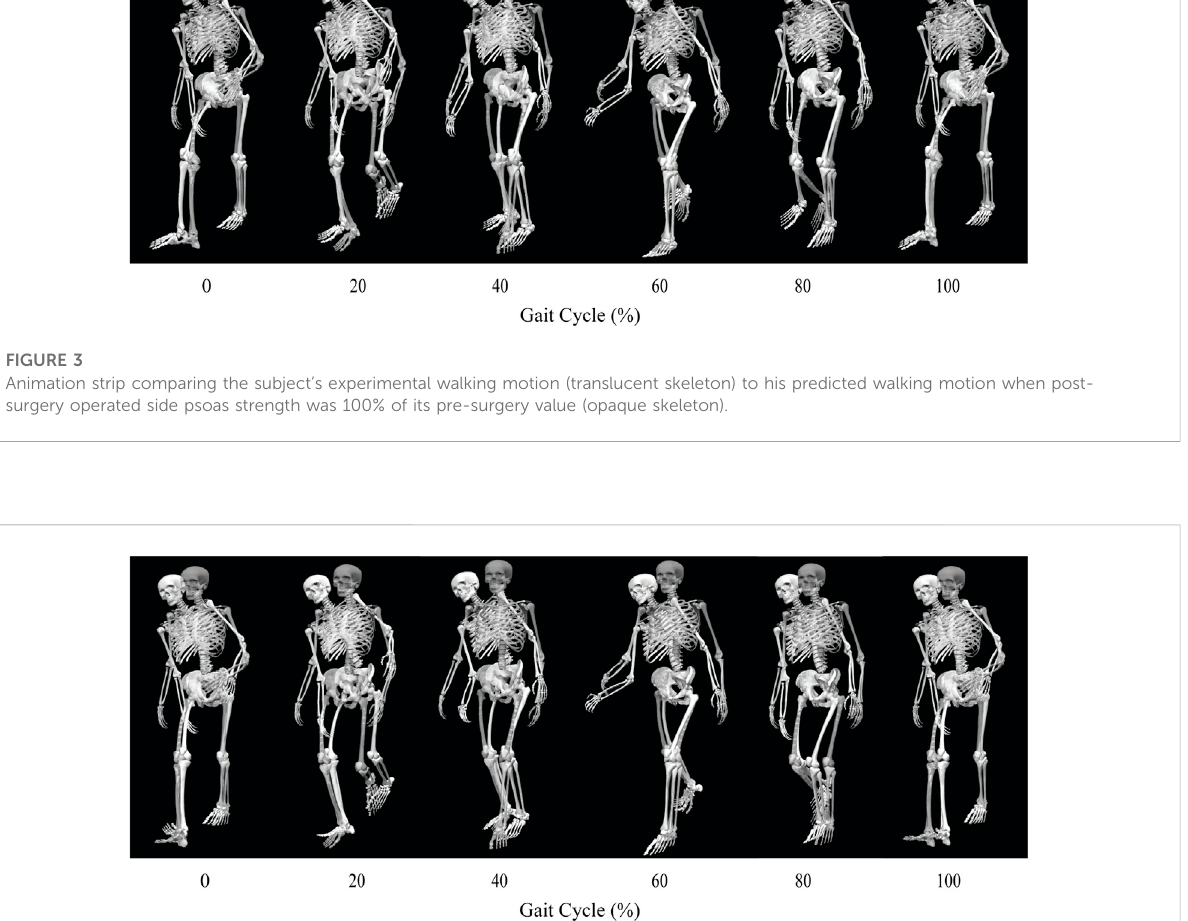
Frontiers in Bioengineering and